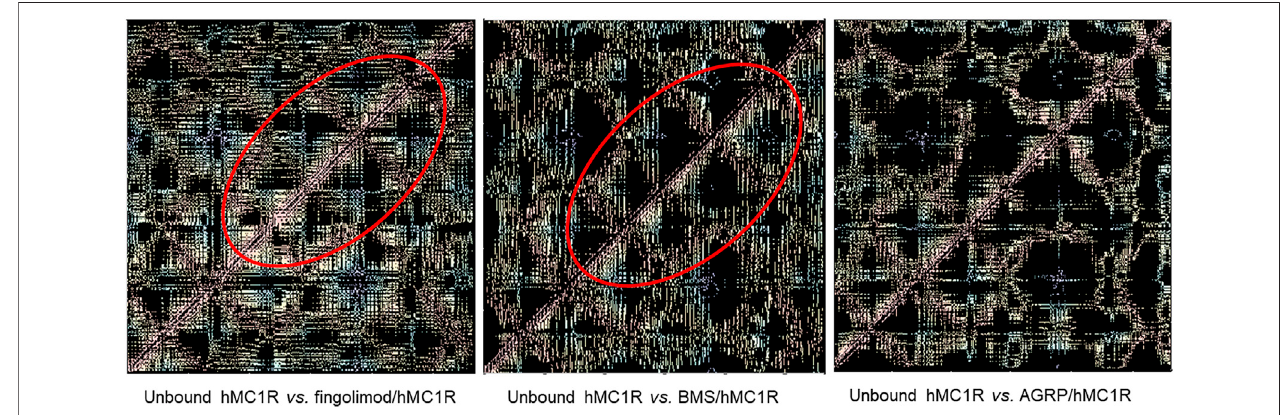
FIGURE 8 | Differences in residue-residues contact maps in hMC1R bound to fi ngolimod and selective agonist (BMS) and antagonist (AGRP).